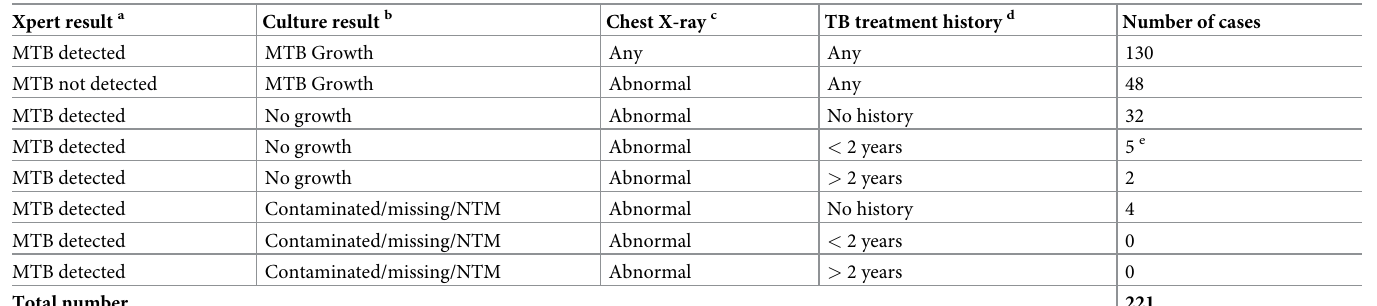
Table 1. Classification of bacteriologically confirmed cases according to expert panel